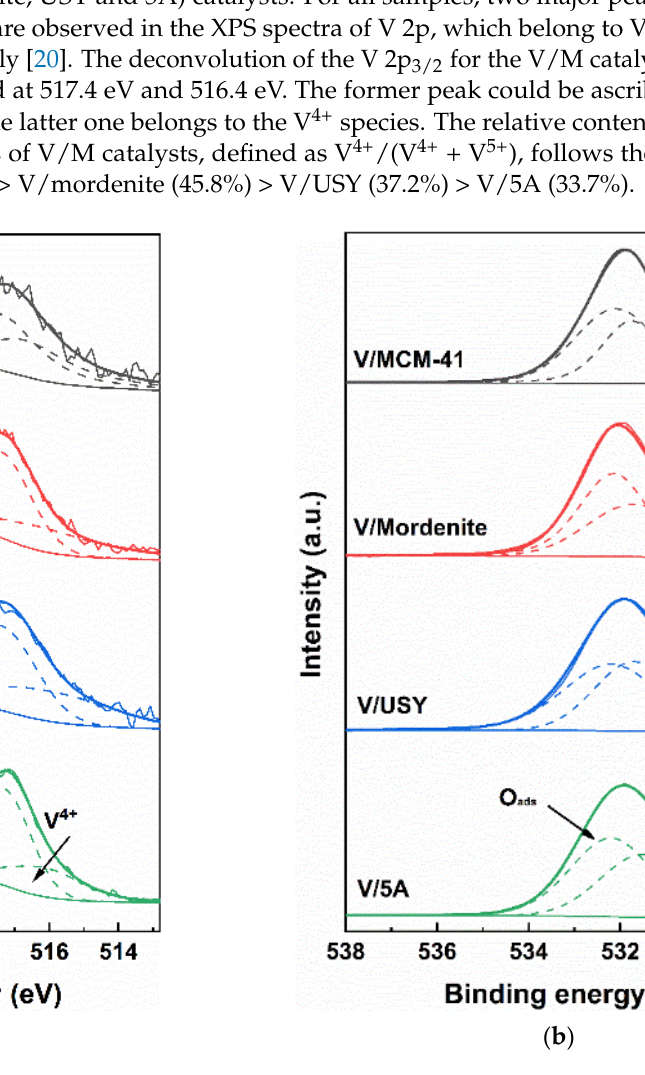
Figure 2. XPS spectra of the V/M (M = MCM-41, mordenite, USY and 5A) catalysts: ( a ) V 2p, ( b ) O 1s.